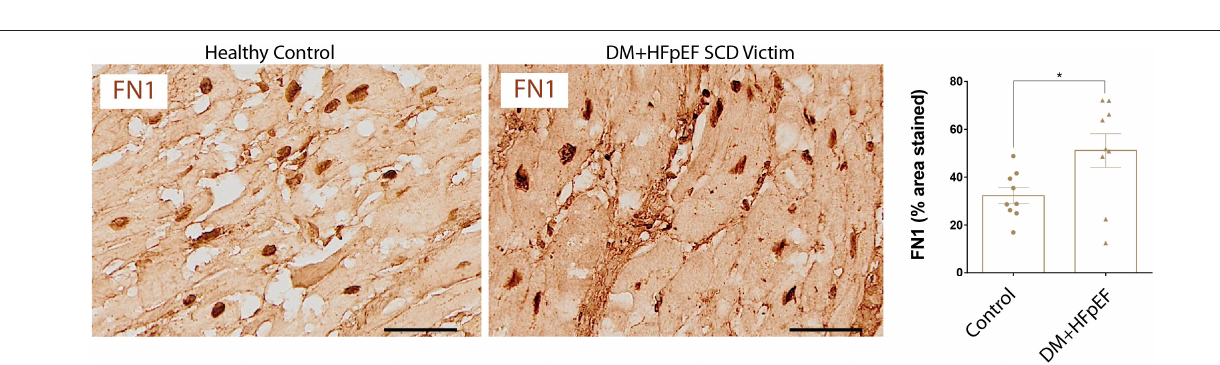
FIGURE 3 | Upregulation of FN1 protein in SCD victims with DM + HFpEF. Immunostaining of cardiac biopsies of SCD victims with both HFpEF and DM shows higher FN1 protein expression compared to control hearts. Data are mean ± SEM. N = 9 subjects/group. Scale bar = 50 µ m. HFpEF, Heart Failure with Preserved Ejection Fraction; DM, Diabetes Mellitus; FN1, Fibronectin 1. * P < 0.05 using Student’s t